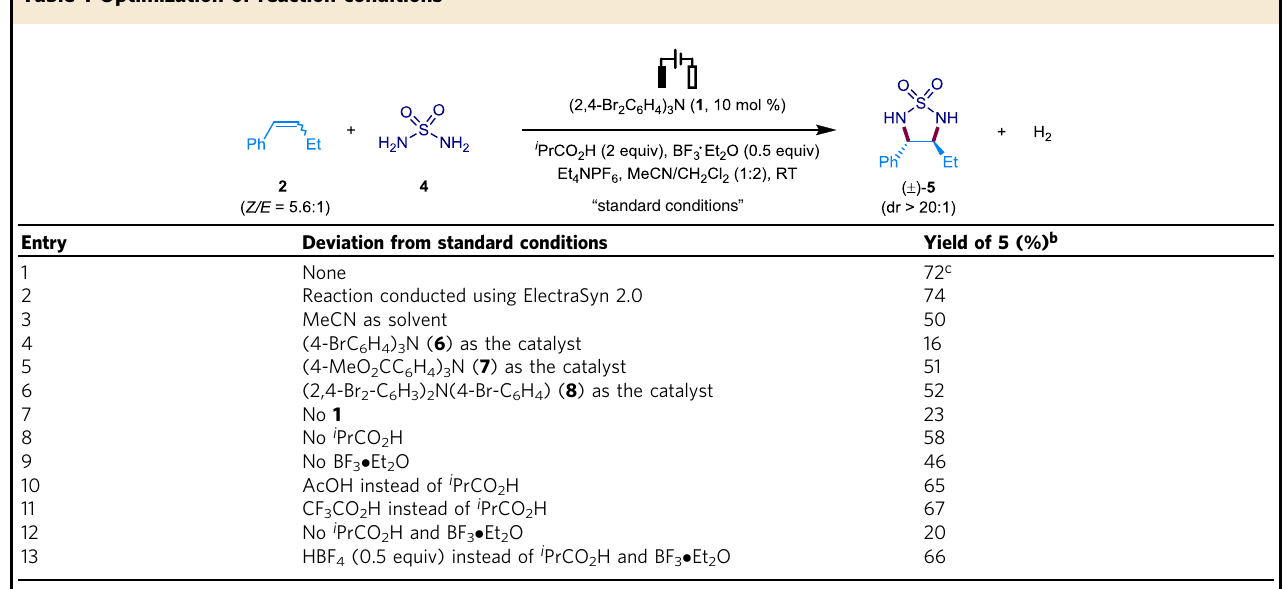
Table 1 Optimization of reaction conditions a